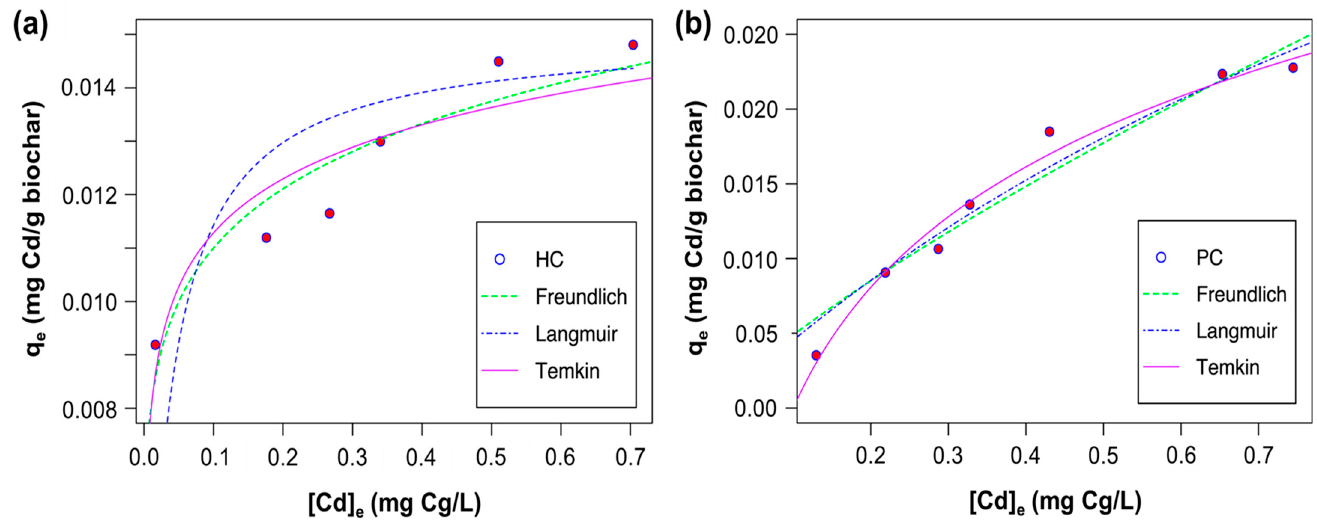
Figure 9. Adsorption isotherms for ( a ) HC and ( b ) PC. Table 5. Langmuir, Freundlich and Temkin constants for Cd adsorption isotherms on HC and PC.